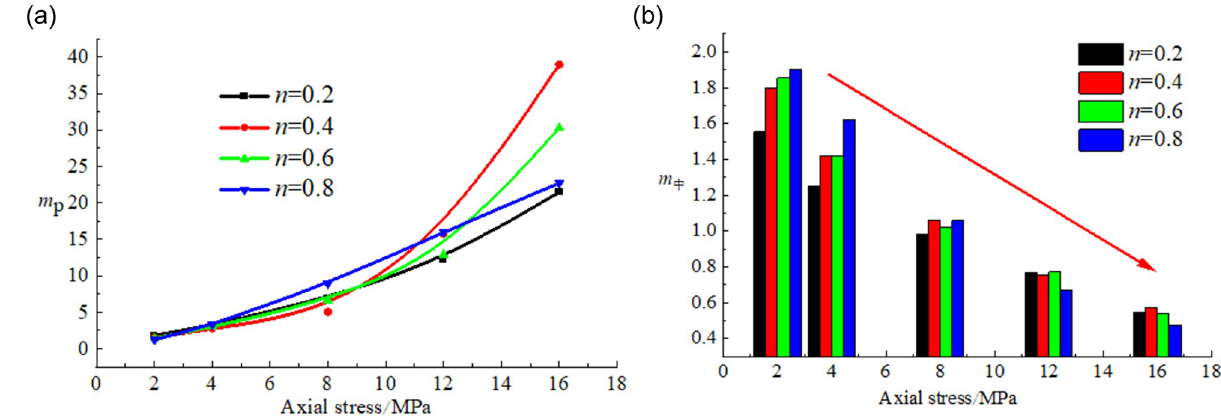
Fig 10. Variation in m